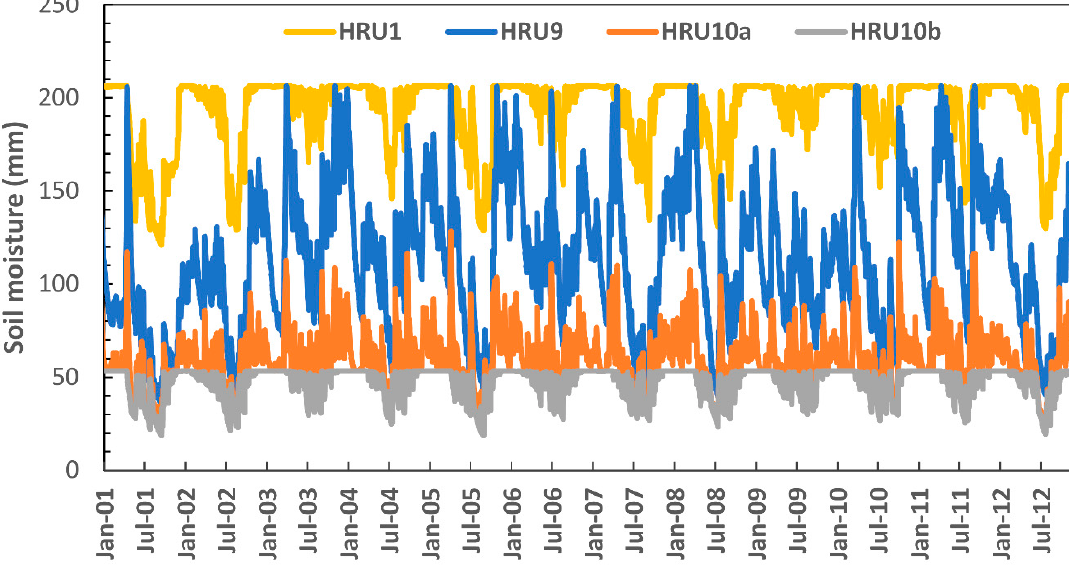
Figure 6. Soil water content of HRUs 1, 9, 10a, and 10b.